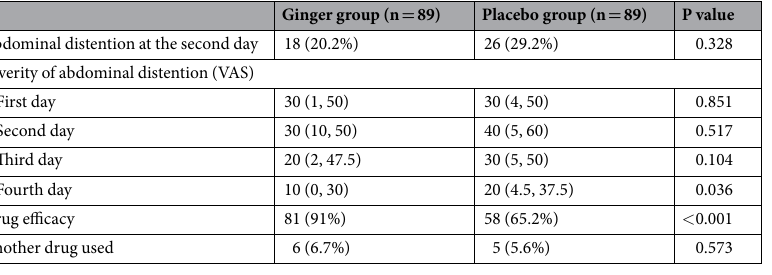
Table 2. Abdominal distention on the second day after operation, severity of abdominal distention on the first four days after operation, and drug efficacy. Data presented as n (%) or median (interquartile range). VAS: visual analogue scale.